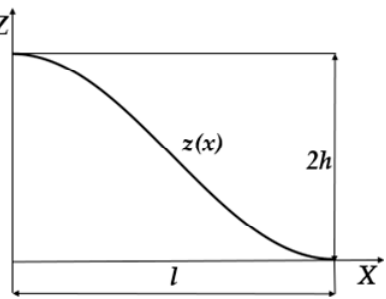
Figure 1. Schematic of the 2D curve of the axisymmetric cosinusoidal